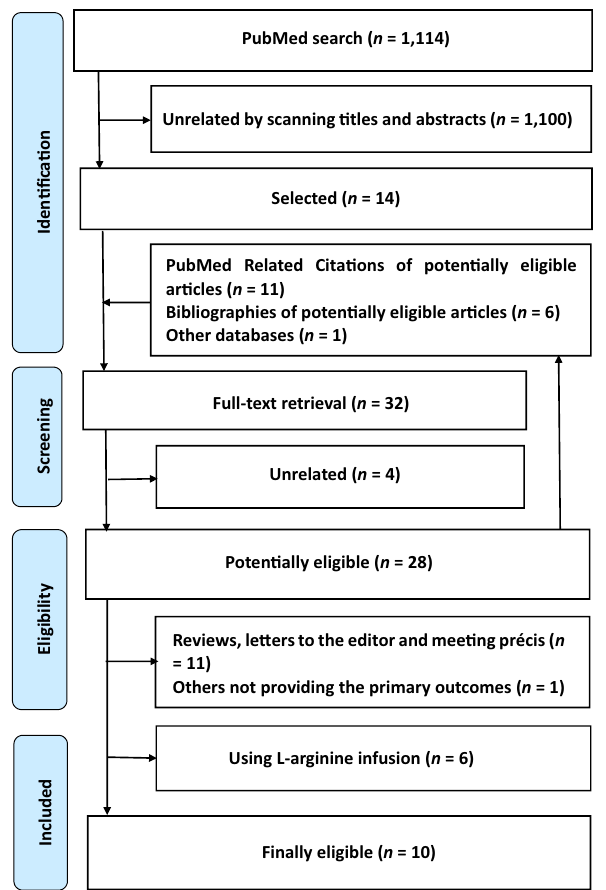
Figure 1. Meta-analysis flow diagram. By excluding 1100 articles determined to be unrelated by scanning the titles and abstracts, 14 articles were selected from 1114 articles identified by PubMed search. With the inclusion of 18 articles by additional investigations, 32 articles were subjected to full-text retrieval. After excluding four unrelated articles, 28 articles were considered to be potentially eligible. Following the exclusion of 18 articles describing studies that did not satisfy the inclusion criteria, 10 articles were finally eligible for the analysis 17–26 . A single article sometimes reported two or more studies among which birth outcomes were different. For example, an article by Camarena Pulido et al. reported a study that evaluated intrauterine growth retardation (IUGR) neonates, another study that evaluated pre-term birth and the other study that evaluated birthweight (Table 1) 17 . Of 10 finally eligible articles, therefore, seven, three, two, two, three, two, two and two studies (i.e., a total of 23 studies) were extracted to evaluate IUGR neonates, pre-term delivery, abortion, infection, respiratory distress syndrome, intracranial hemorrhage, neonatal intensive care unit admission and cesarean section, respectively (Table 1, Figs. 2 and 3 and Supplementary Tables 1 and 2). Eight, two, five and seven studies (i.e., a total of 22 studies) were extracted to evaluate birthweight, birth length, pregnancy duration and Apgar score, respectively. No or only one study that could not be subjected to meta-analysis was extracted to evaluate any other outcome. Therefore, a total of 45 studies involving 5763 mother–neonate pairs in five developing and developed countries in Asia, Europe and Latin America that were extracted from the 10 finally eligible articles were included in this meta-analysis (Table 1, Figs. 2 and 3 and Supplementary Tables 1 and